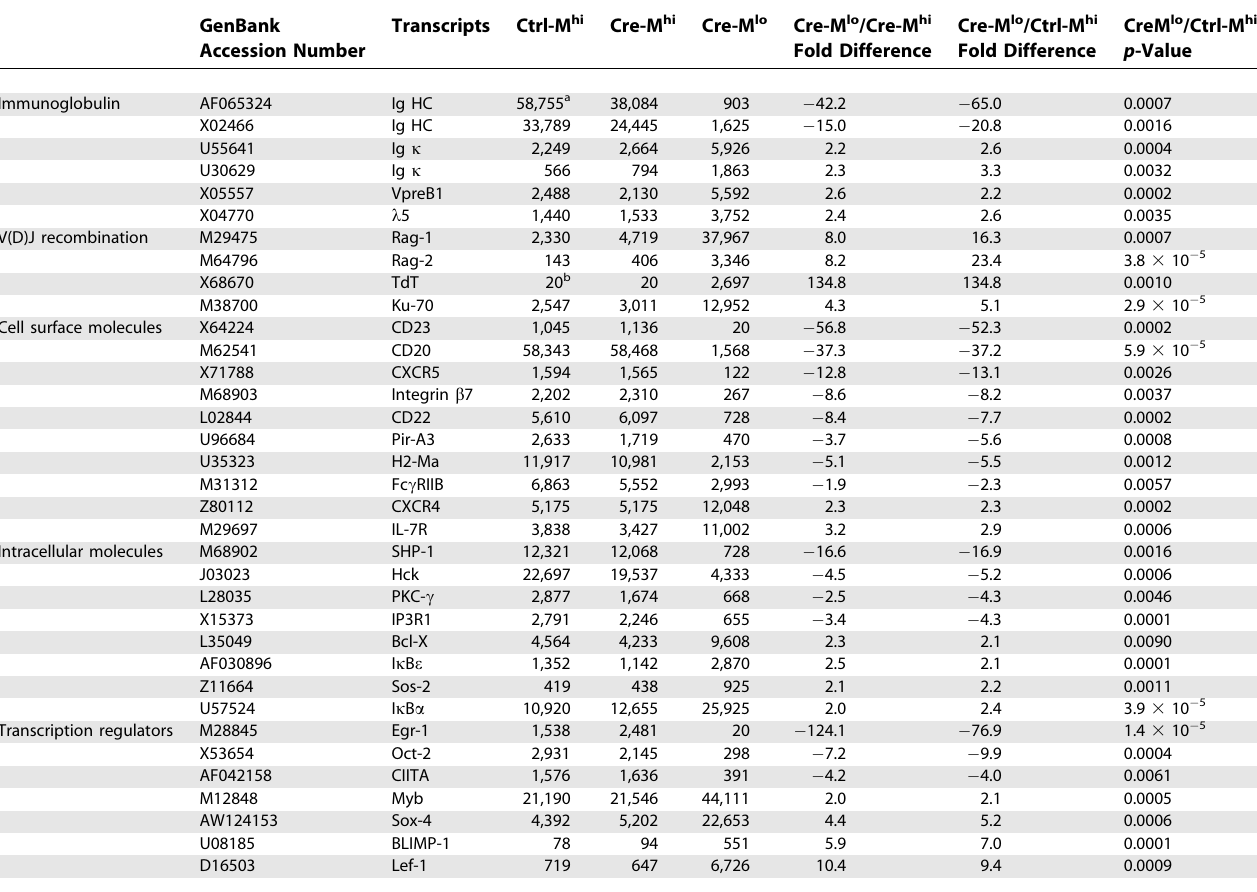
Table 1. Representative Gene Expression in Cells Undergoing Cre-Mediated Deletion of IgM GenBank Accession Number